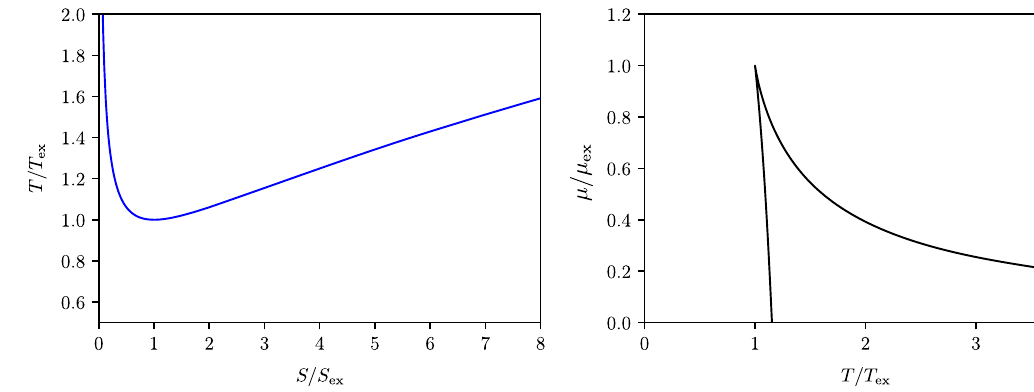
Fig. 3 T − S and μ − T curves at fixed (cid:5)